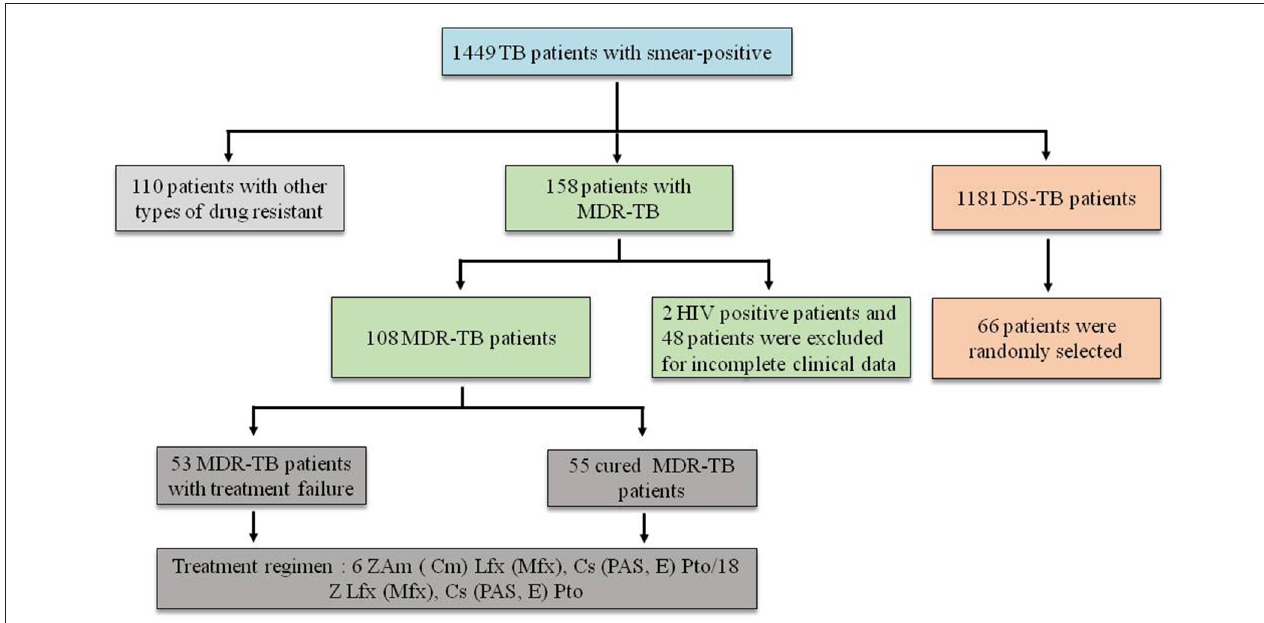
FIGURE 1 | Screening of patients. Z, pyrazinamide; Am, amikacin; Cm, capreomycin; LFX, levofloxacin; MFX, moxifloxacin; CS, cycloserine; PAS, p-aminosalicylic acid; E, ethambutol; PTO, prothionamide.